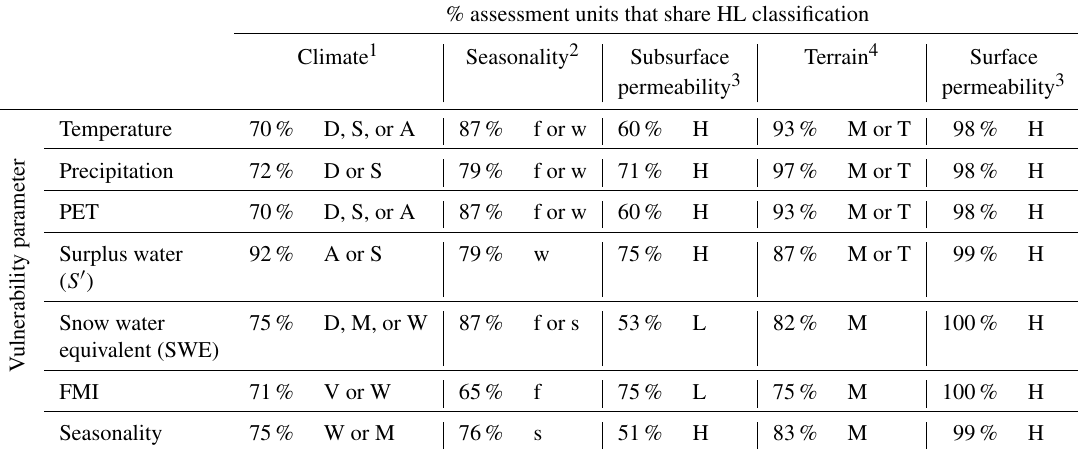
Table 4. Hydrologic landscape characteristics of assessment units identified as vulnerable (having a vulnerability index greater than 7 on a scale of 10) for each